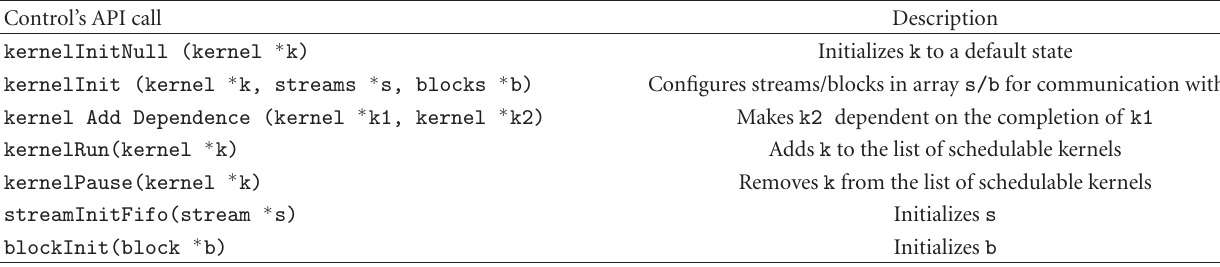
Table 1: Redsharc control kernel ’ s API calls.